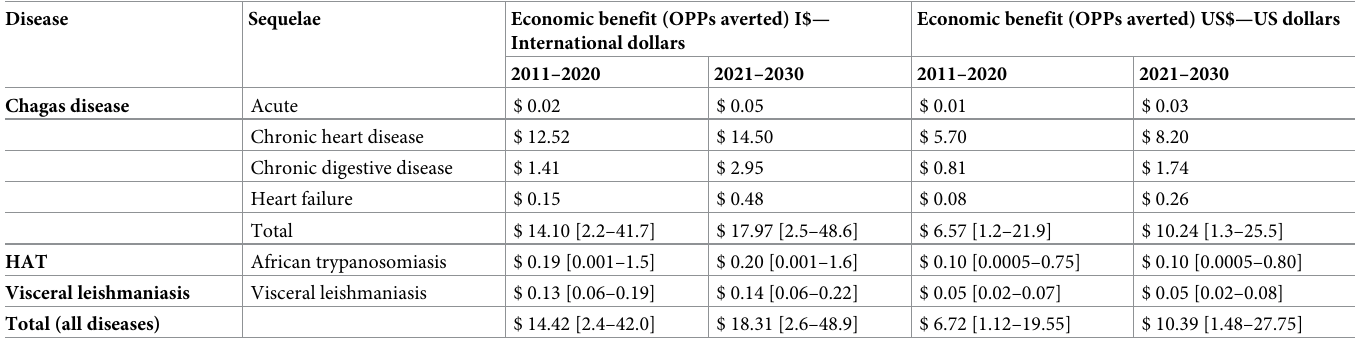
Table 7. Total economic benefit from out-of-pocket payments averted, base case estimates and 2.5 th and 97.5 th percentiles (billions I$—International dollars and US$—US dollars) discounting 3% from 2010. Disease